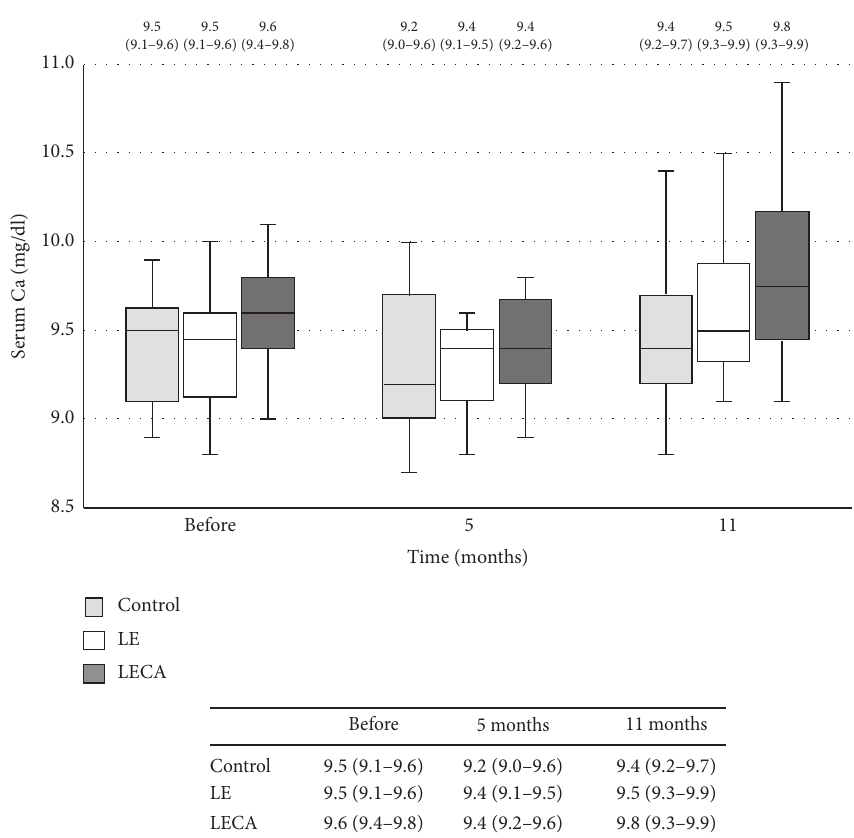
Figure 6: Changes in serum total Ca concentration in each group (chronological). Values are shown as the median (interquartile range) (25%–75%) with error bars. Light grey box is the control group, blank box is the LE group, and dark grey box is the LECA group. Friedman’s test with type of ingested product and intervention period as factors was used. p values for each group are shown ( ‡ ). Control: p � 0.616 ‡ ; LE: p < 0.001 ‡ ; LECA: p < 0.001 ‡ . Ca: